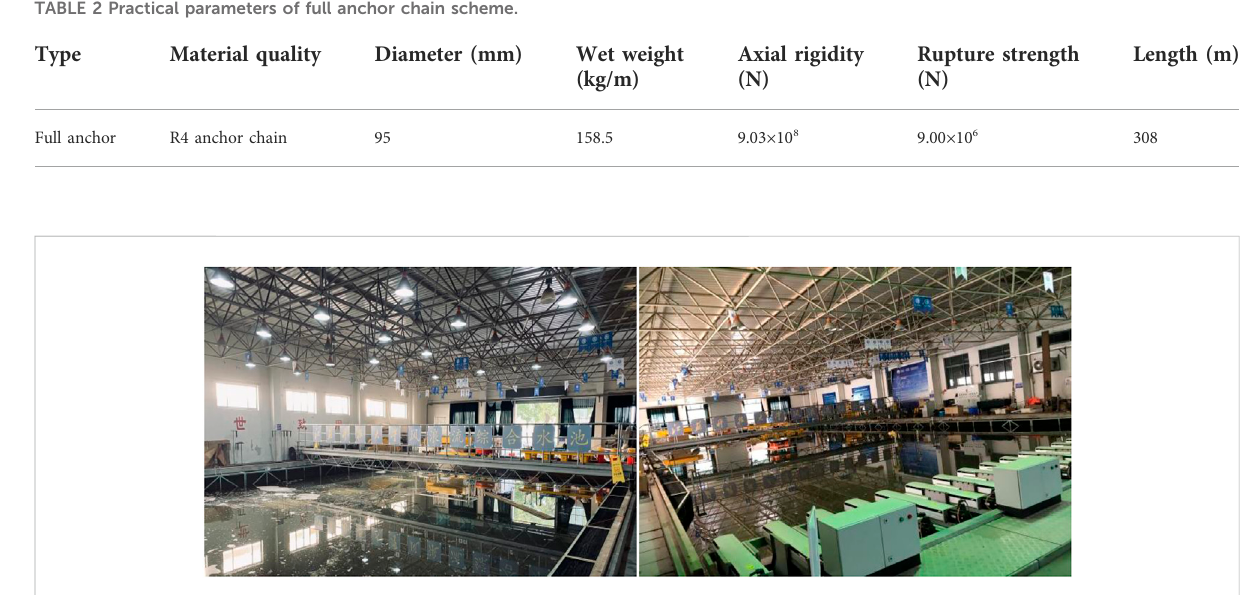
FIGURE 3 Panoramas of wind-wave-current comprehensive